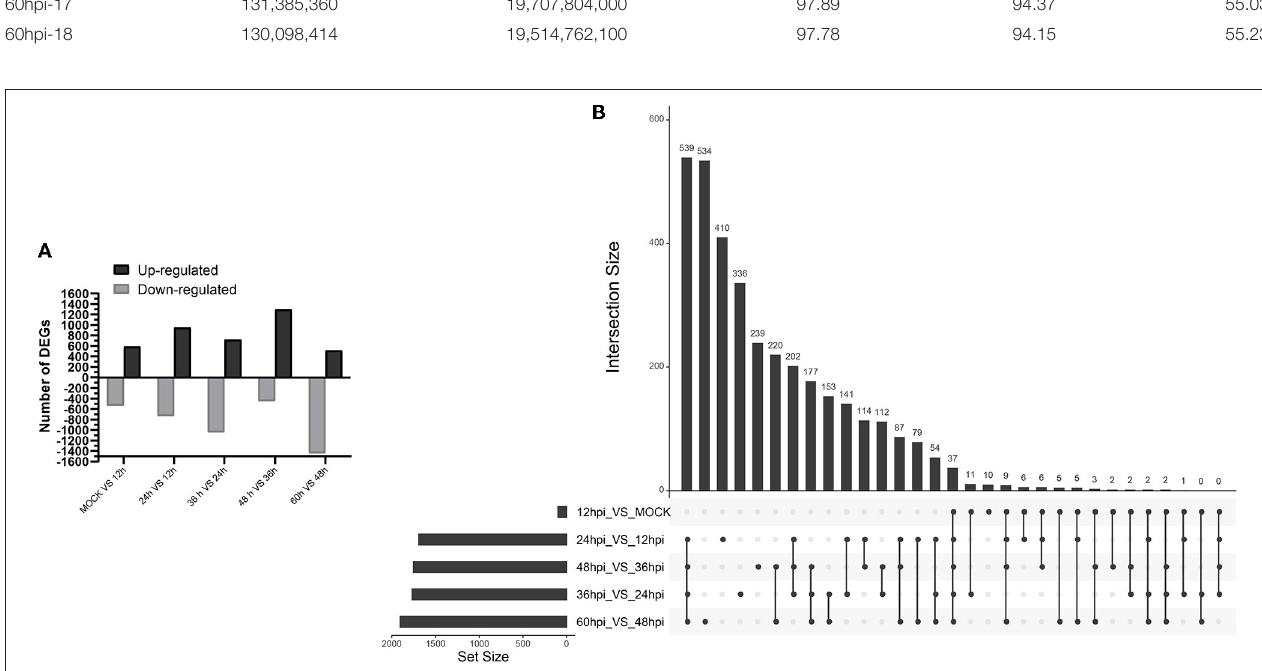
FIGURE 2 | Identification and clustering of DEGs. (A) Number of differentially expressed genes at five time points after infection with FAdV-4. (B) Up Set plot showing unique and common DEGs in response to infection with FAdV-4 at five time points.